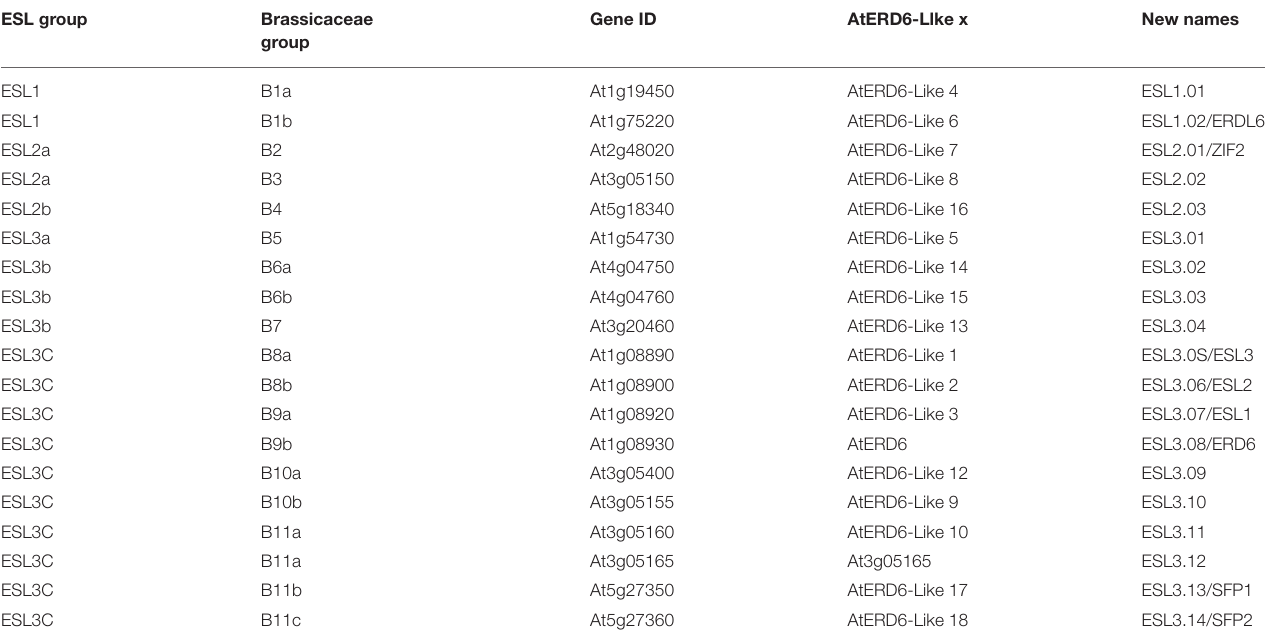
TABLE 1 | Nomenclature of Arabidopsis thaliana early response to dehydration six-like ( ESL )